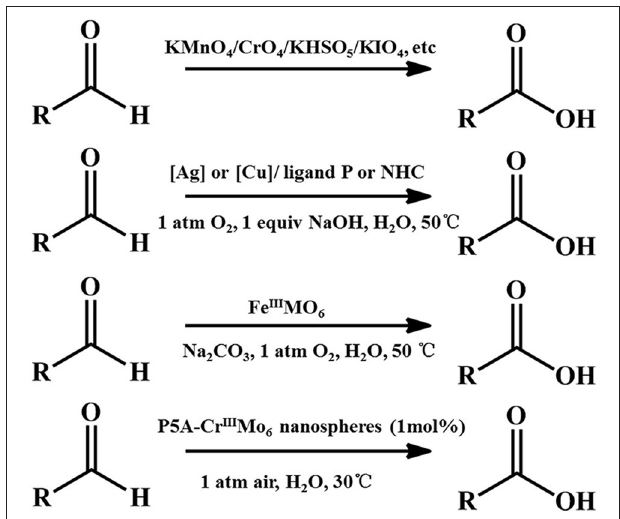
FIGURE 4 | Representative examples of oxidation of aldehydes.